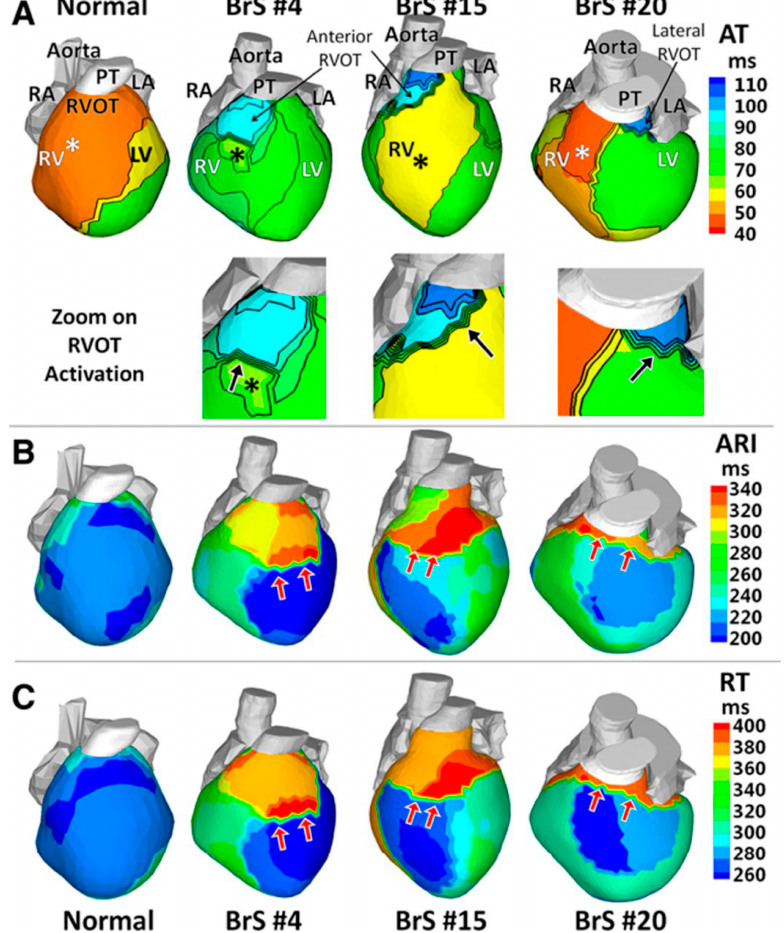
Figure 2. Activation and repolarization during sinus rhythm. ( A ) Activation times isochrone maps (AT). Insets, zoom on the RVOT. ( B ) Activation-recovery interval maps (ARI). ( C ) Recovery time (RT) maps. Epicardial breakthroughs are indicated by asterisks. Isochrones are depicted in thin black lines. Black arrows in the RVOT zoom maps of A point to slow conduction indicated by crowded isochronal lines. Red arrows in B and C point to regions with steep repolarization gradients. BrS indicates Brugada syndrome; LA, left atrium; LV, left ventricle; PT, pulmonary trunk; RA, right atrium; RV, right ventricle; and RVOT, right ventricular outflow tract. Modified from Zhang et al., Cardiac electrophysiological substrate underlying the ECG phenotype and electrogram abnormalities in Brugada syndrome patients, Circulation, Volume 131, Issue 22, page 1954. http://circ.ahajournals.org/content/131/22/1950.long